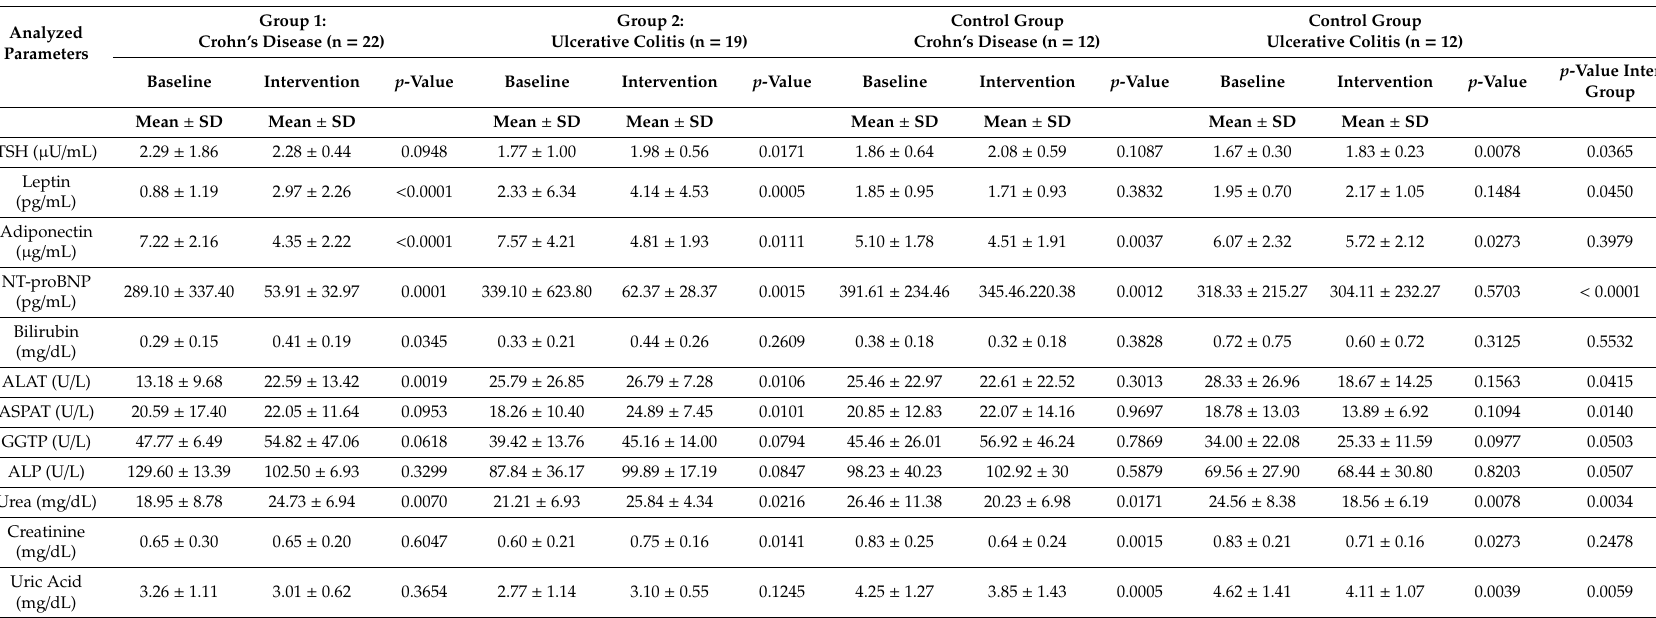
Table 3. The changes during the combined enteral and parenteral nutrition in selected biomarkers in IBD patients (n = 65). Analyzed